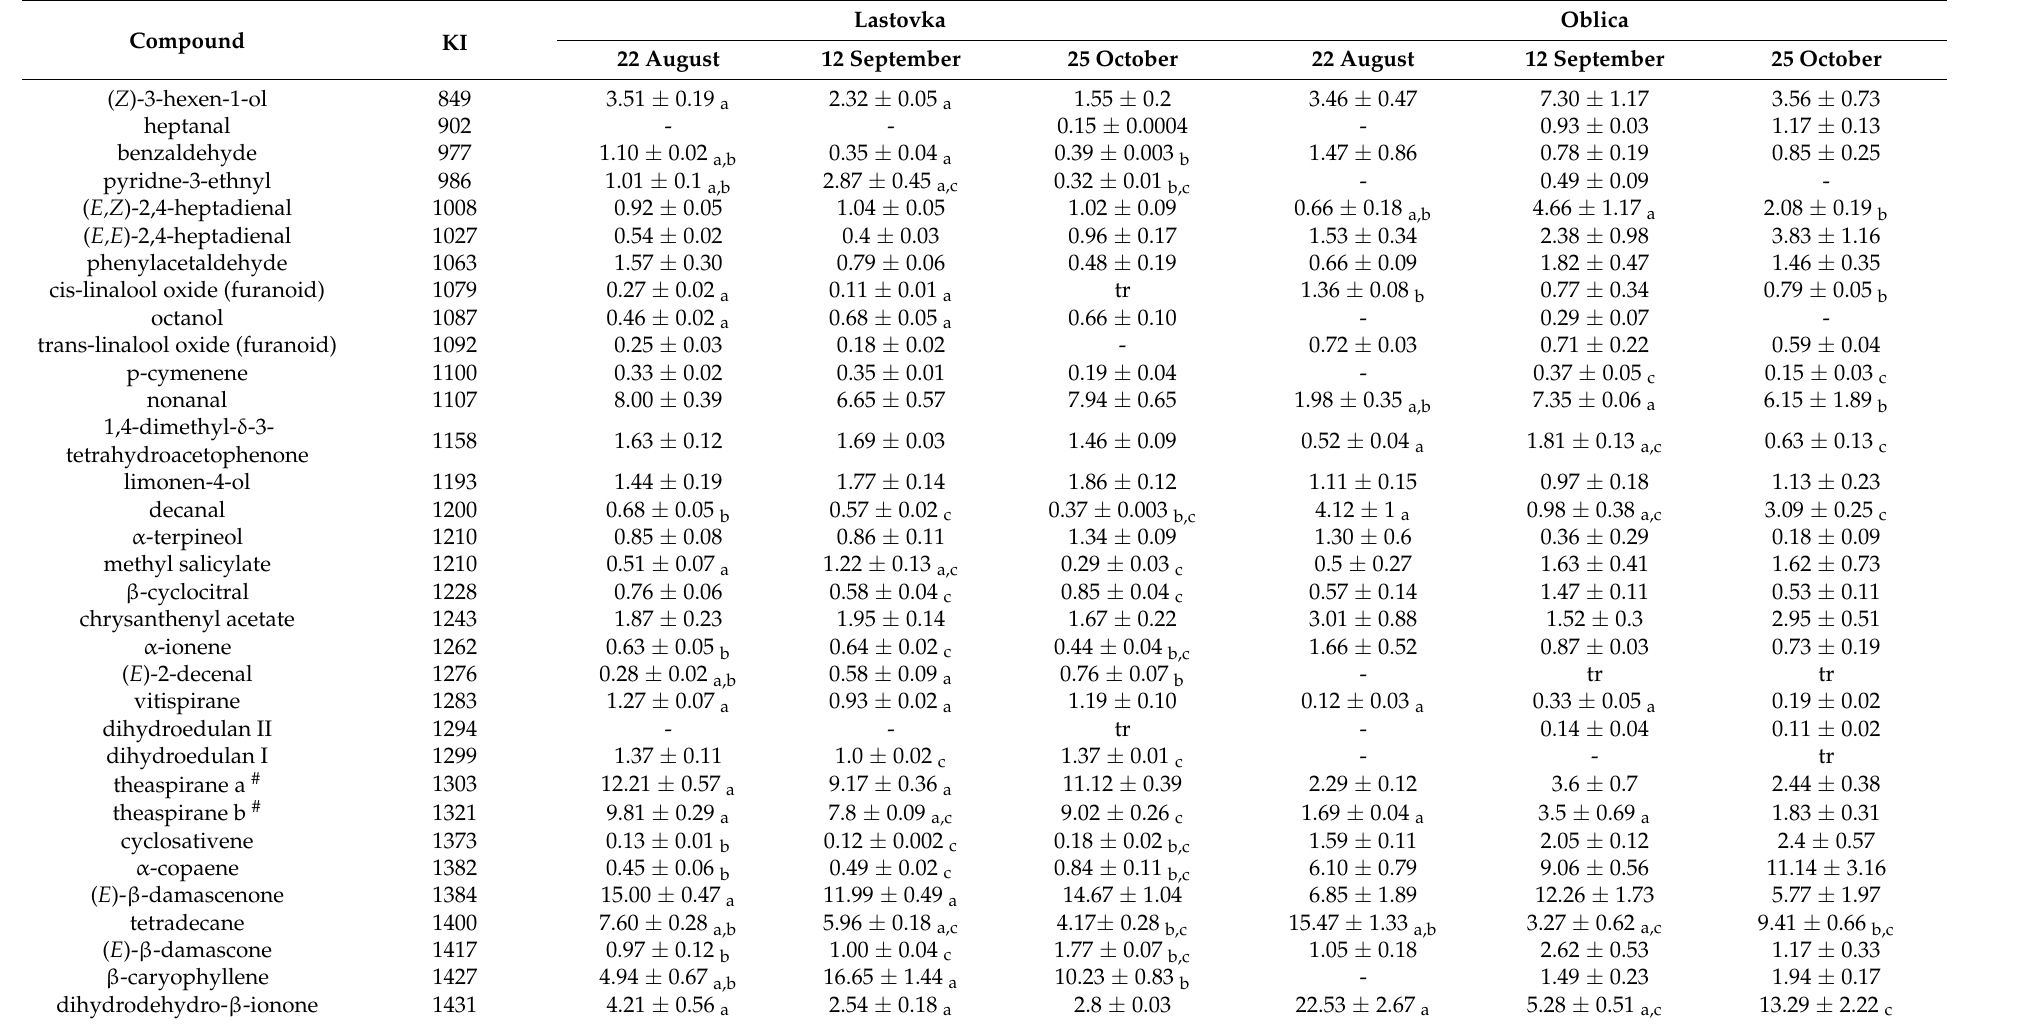
Table 1. Composition of volatiles identified at different harvest periods in essential oils of olive leaves from cvs. Lastovka and